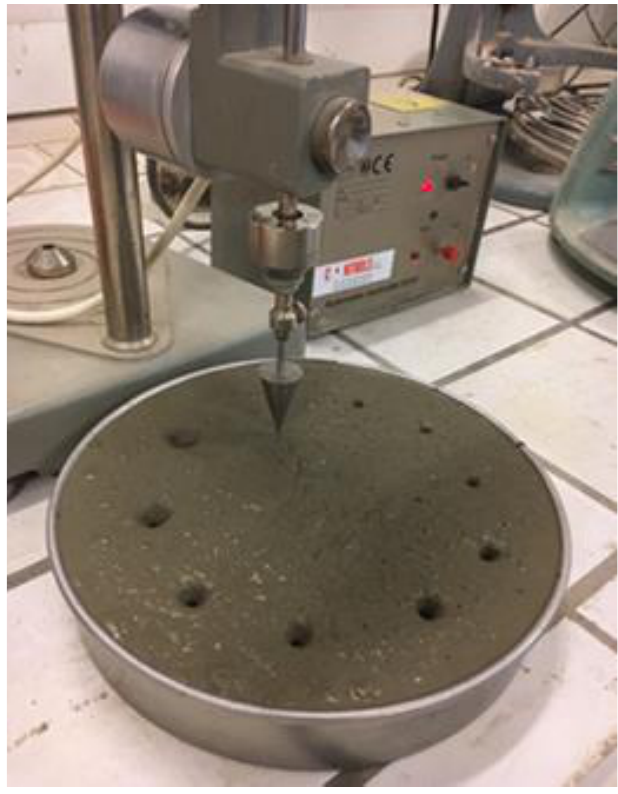
Figure 10. Fall cone test setup.